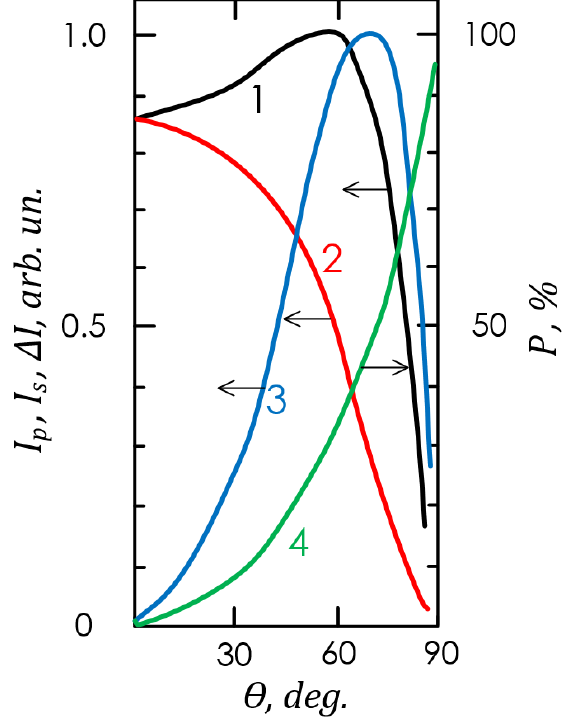
Figure 9. Dependences of photocurrents (1 corresponds 𝐼 (cid:3017) , 2 corresponds 𝐼 (cid:3020) , 3 corresponds 𝛥𝐼 = 𝐼 (cid:3017) − 𝐼 (cid:3020) ) and PPL coefficient (4 corresponds 𝑃 = (cid:3057)(cid:3010) ∙ 100 % ) for surface-barrier structures (Sample No. 5) on the angle of incidence of linearly polarized radiation ( λ = 0.437 µm, illumination is from the side of the barrier contact, T = 300 K).